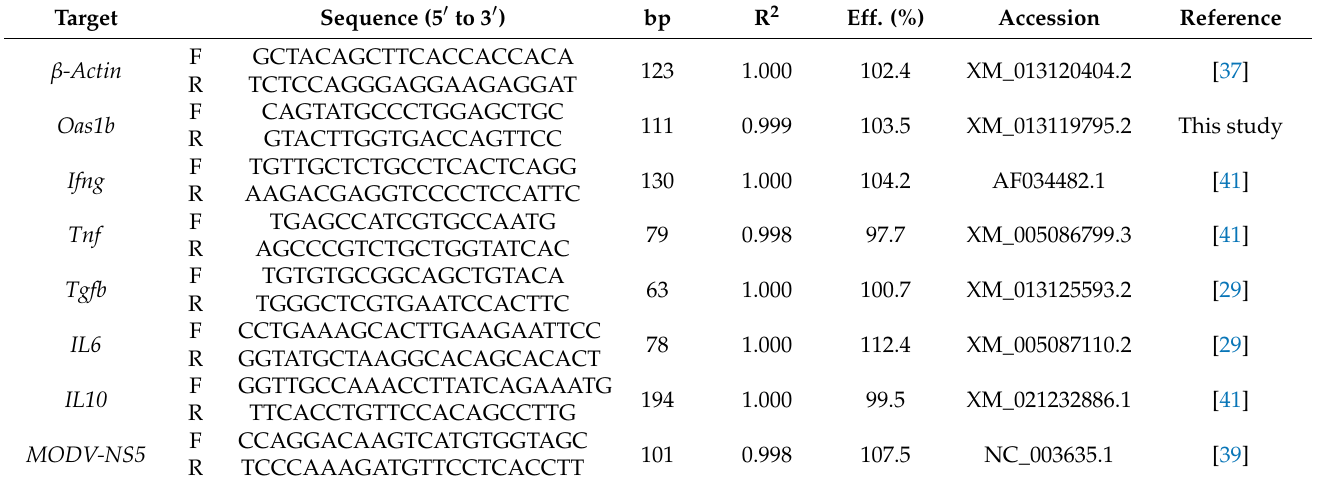
Table 2. Sequence data and amplification efficiency for Mesocricetus auratus